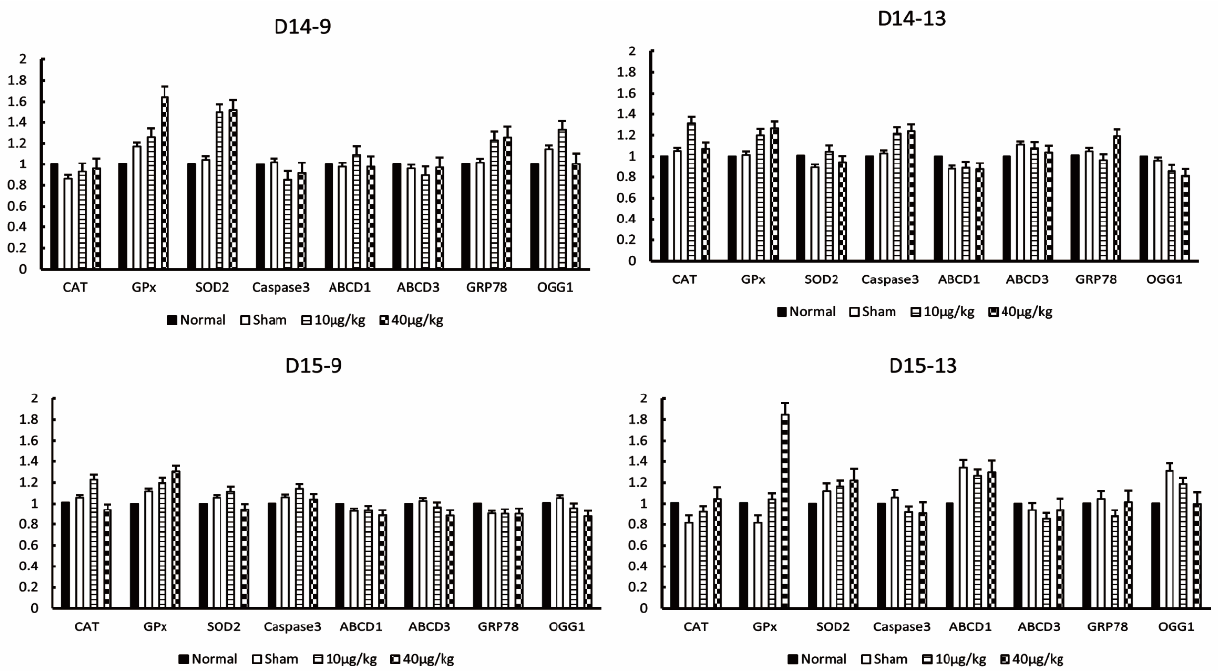
Figure 6. Effects of DEX administration on oxidant stress factors in the mouse testes. The expression levels of catalase (CAT), glutathione peroxidase (GPx), superoxide dismutase 2 (SOD2), caspase3, adrenoleukodystrophy protein from subfamily D, member 1 (ABCD1), ABCD, member 3 (ABCD3), glucose-regulated protein, 78kDa (GRP78), and 8-oxoguanine DNA glycosylase 1 (OGG1) at each testis collection point were measured by RT-PCR. The values in the graph are presented as means ± SDs. The sampling points after 14 days of continuous DEX administration were 9:00 on day 14 (D14-9), 13:00 on day 14 (D14-13), 9:00 on day 15 (D15-9), and 13:00 on day 15 (D15-13).